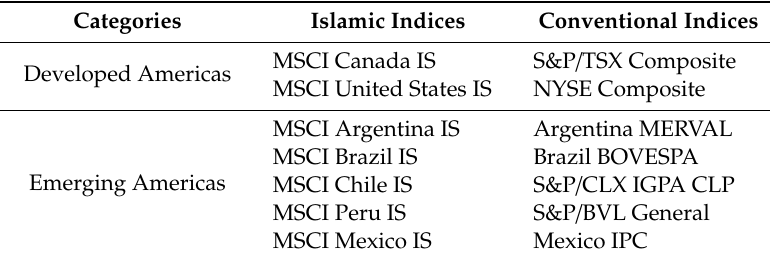
Table 4. The Americas Region’s Islamic and Conventional Stock